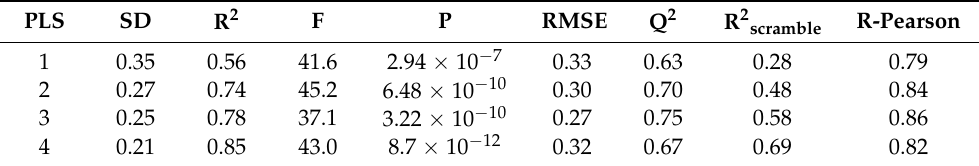
Table 3. Statistical results of the atom-based 3D-QSAR approach for Schiff bases 1–48 .